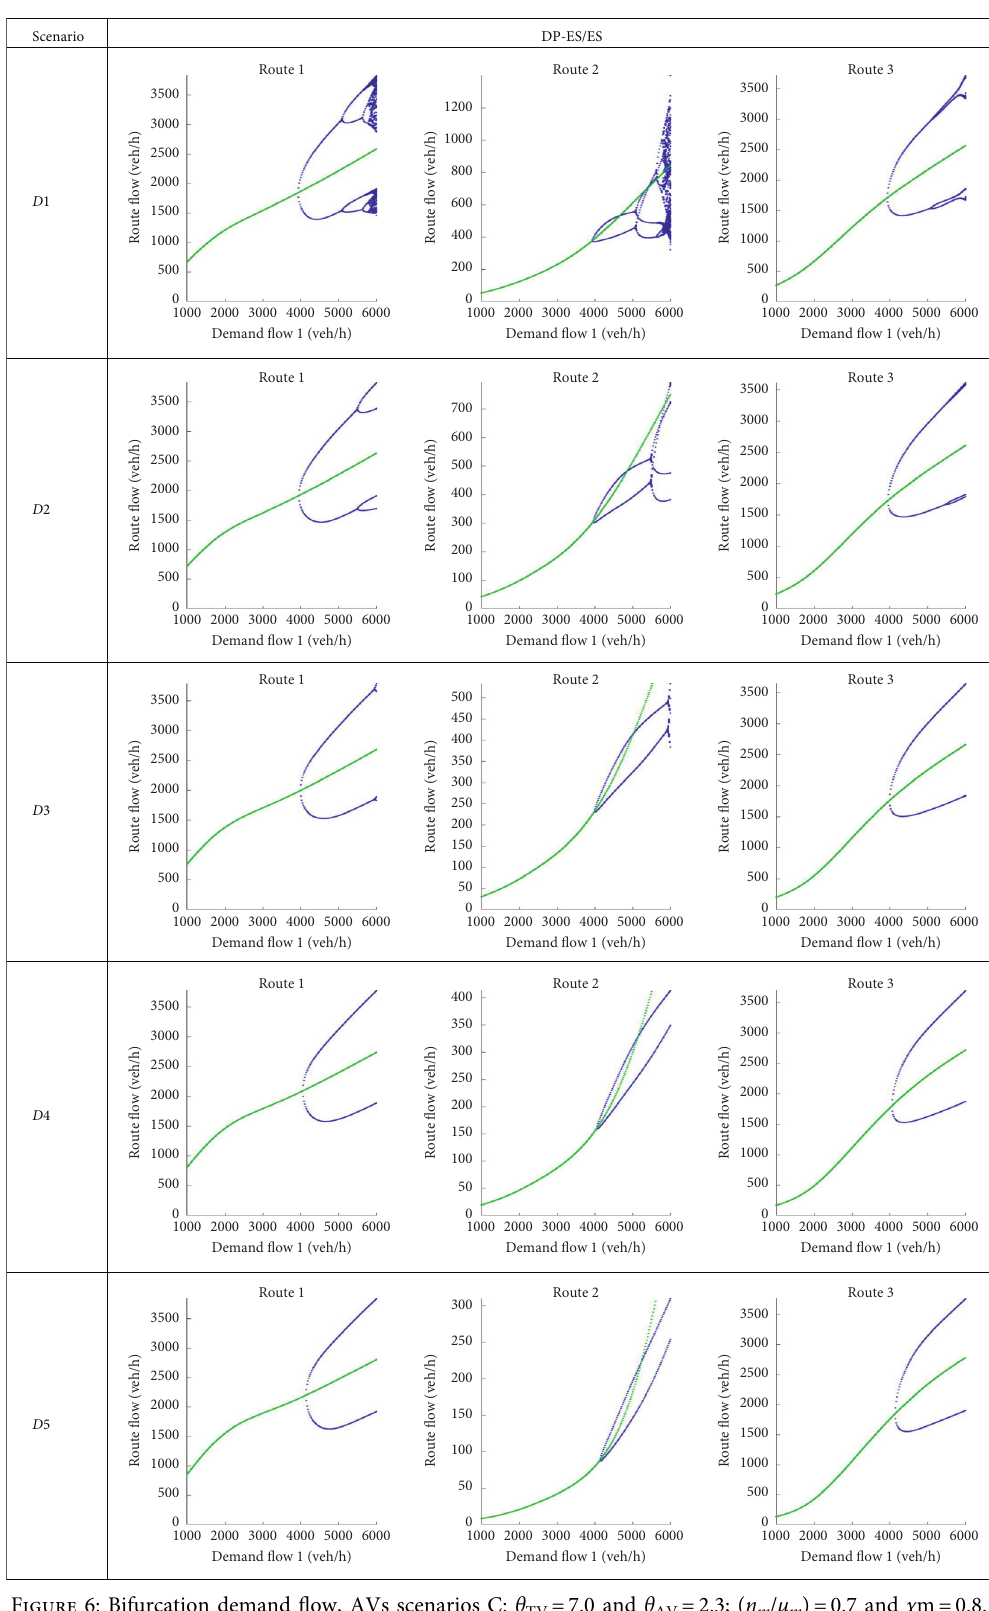
� 7.0 and θ � 2.3; ( η � 0.7 and χ m � TV AV m / μ m )